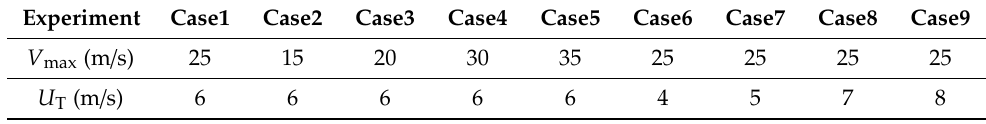
Table 1. Design of numerical experiments. Case 1 is the standard experiment. V max is the maximum wind speed at the radius R max ; U T is the translation speed of the typhoon.